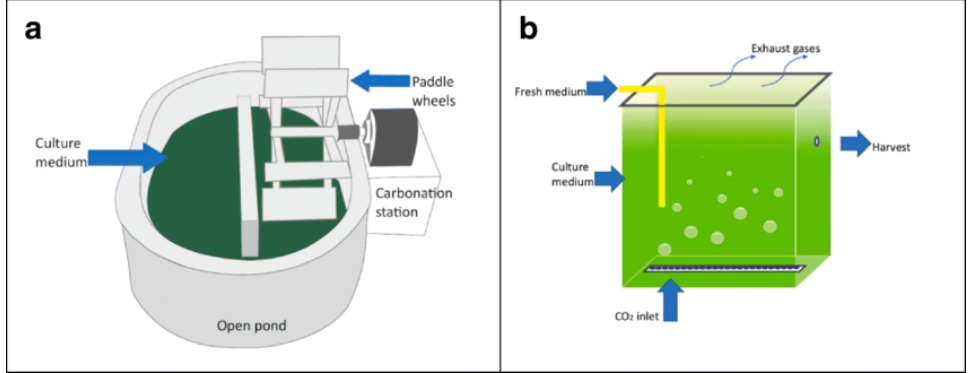
Figure 1. ( a ) Open raceway pond, ( b ) photobioreactor. Reprinted with the permission from [65]. Copyright 2022 Springer